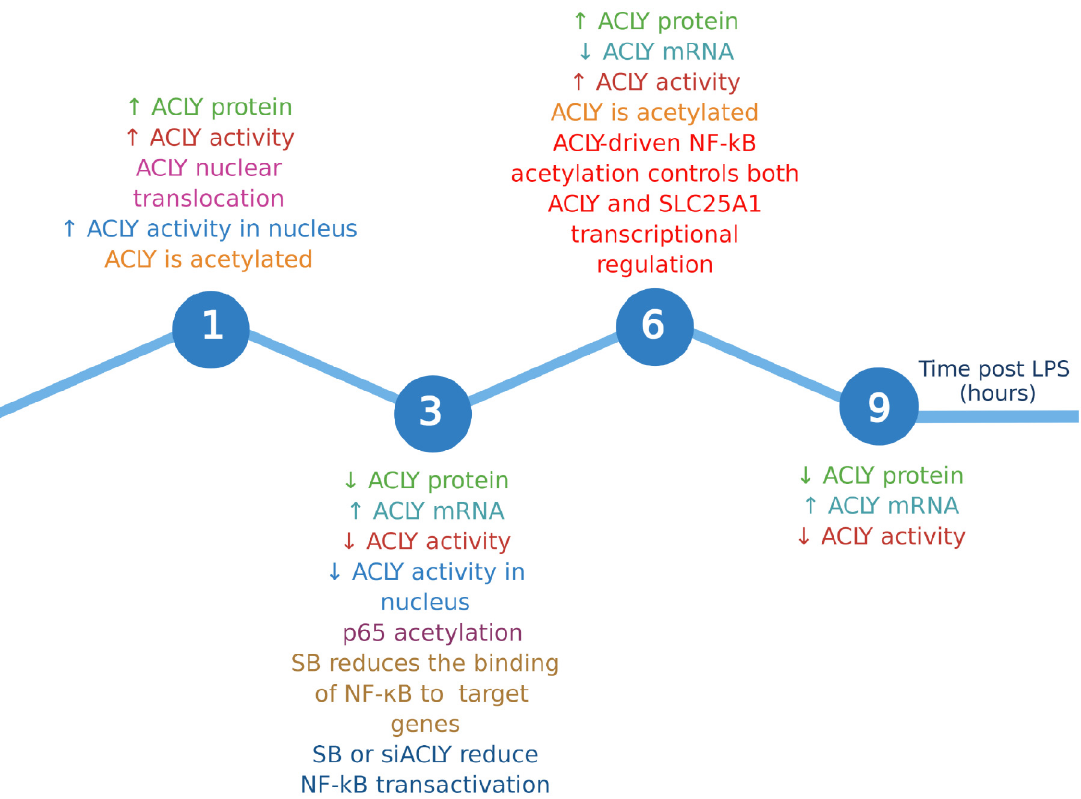
Figure 6. Summary outline showing the timing of the events described in the study. Each event is indicated with a different color. Upward arrows indicate an increase, while downward arrows indicate a reduction to a specific time.